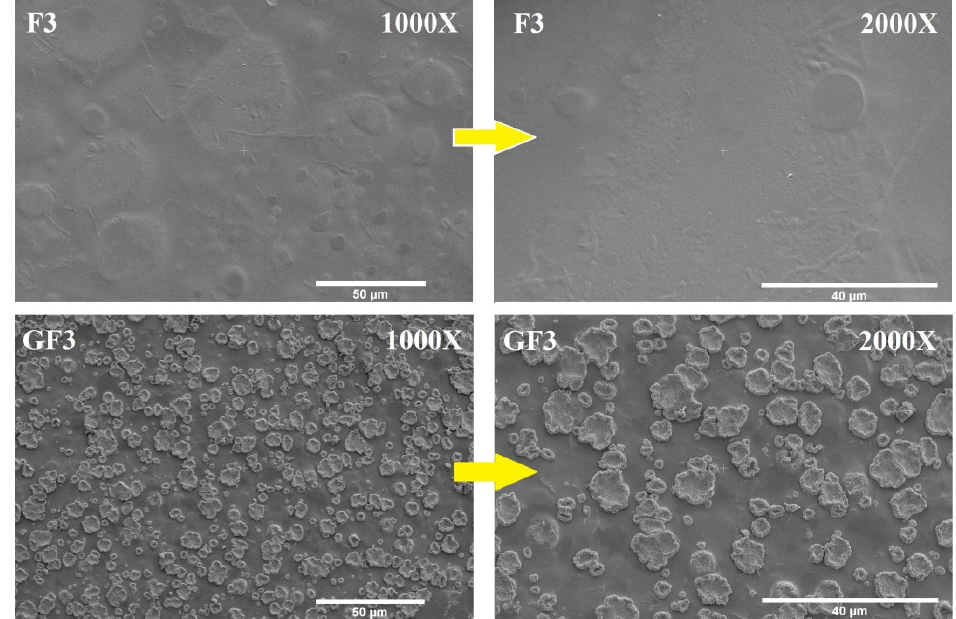
Figure 2. Surface morphology of blank (F3) and GS-loaded (GF3) films.